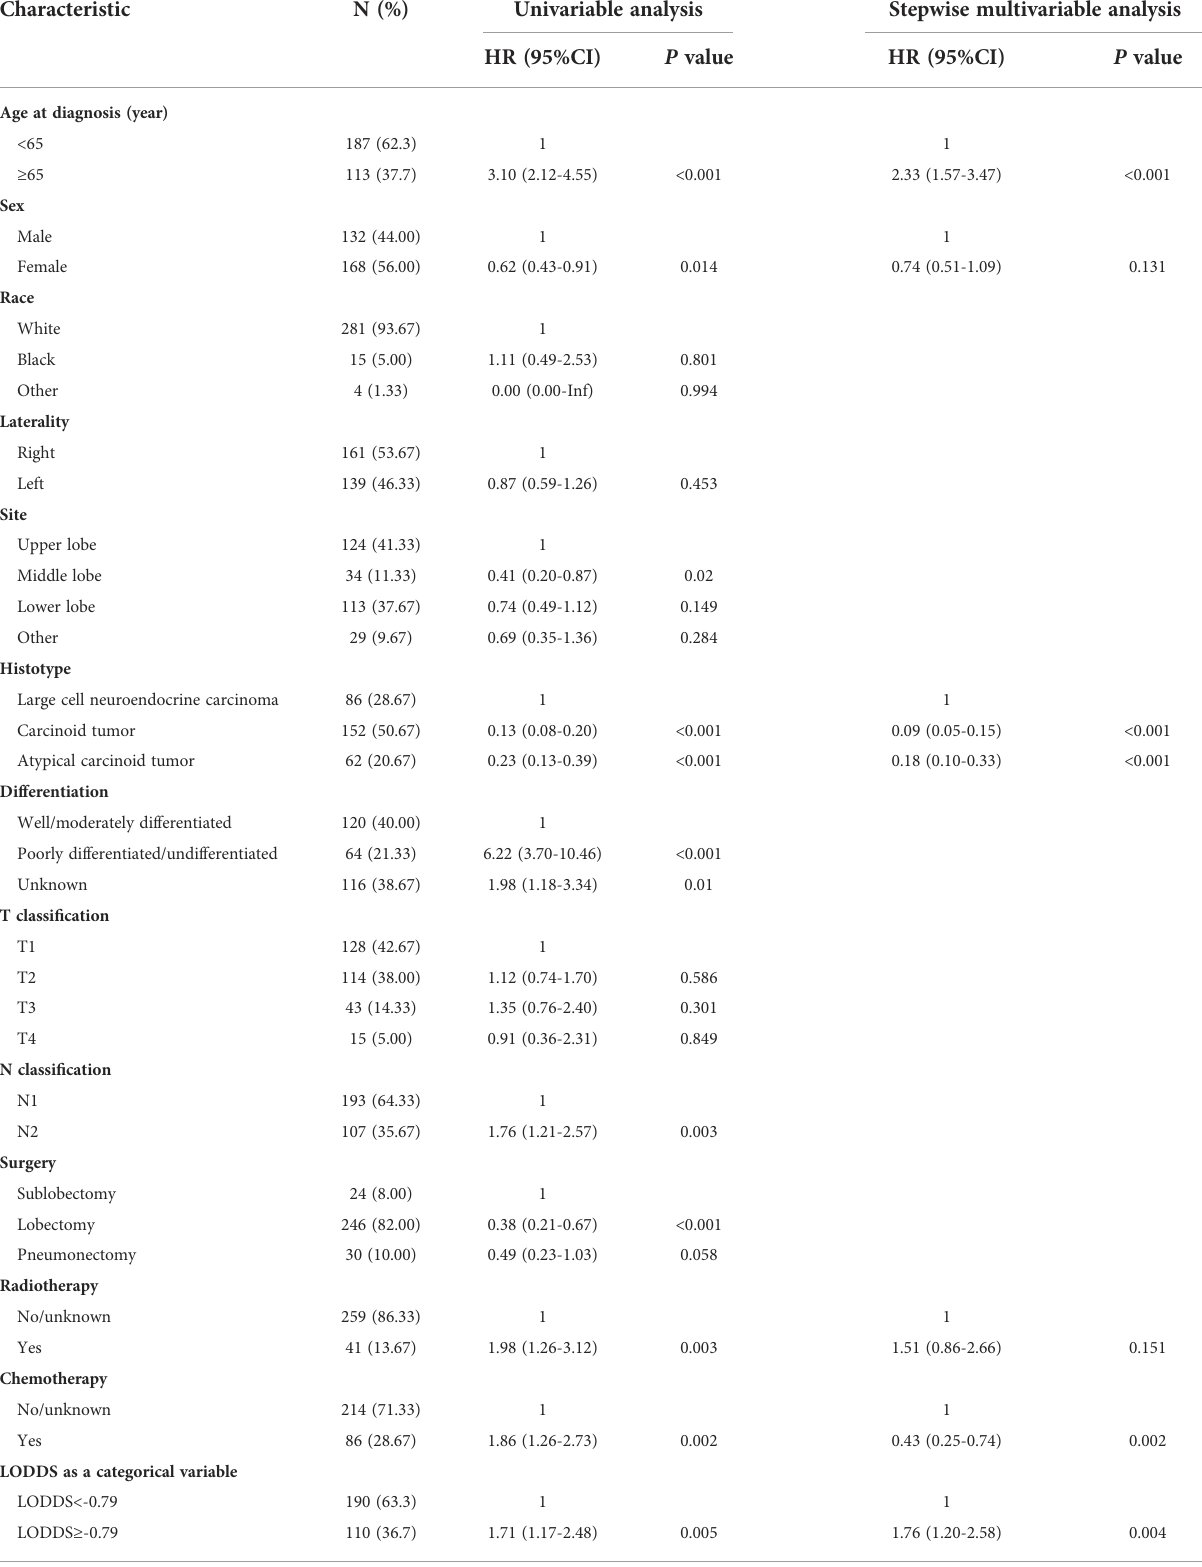
TABLE 3 Univariable and stepwise multivariable Cox proportional regression analysis for OS of the derivation